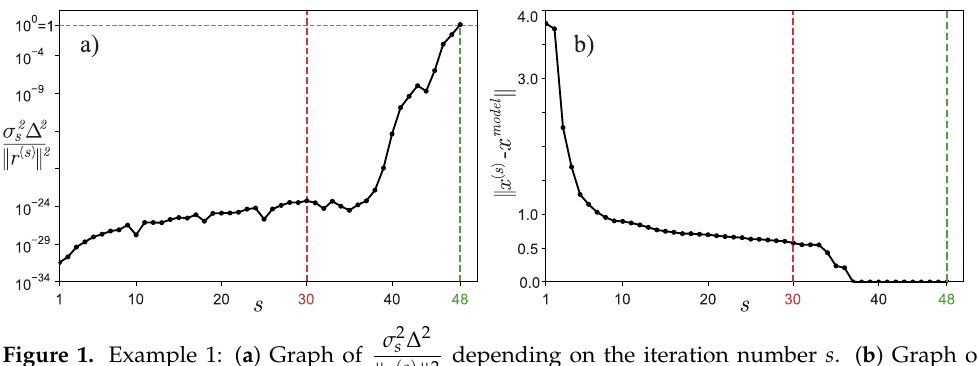
Figure 1. Example 1: ( a ) Graph of (cid:107) x ( s ) − x model (cid:107) depending on the iteration number s